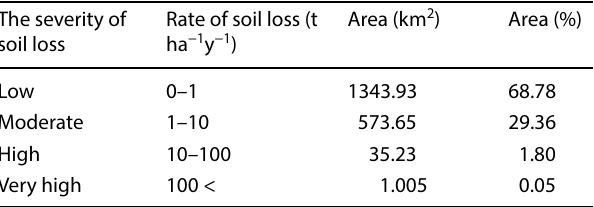
Table 2 Average annual soil loss of the lower Kulsi River basin The severity of soil